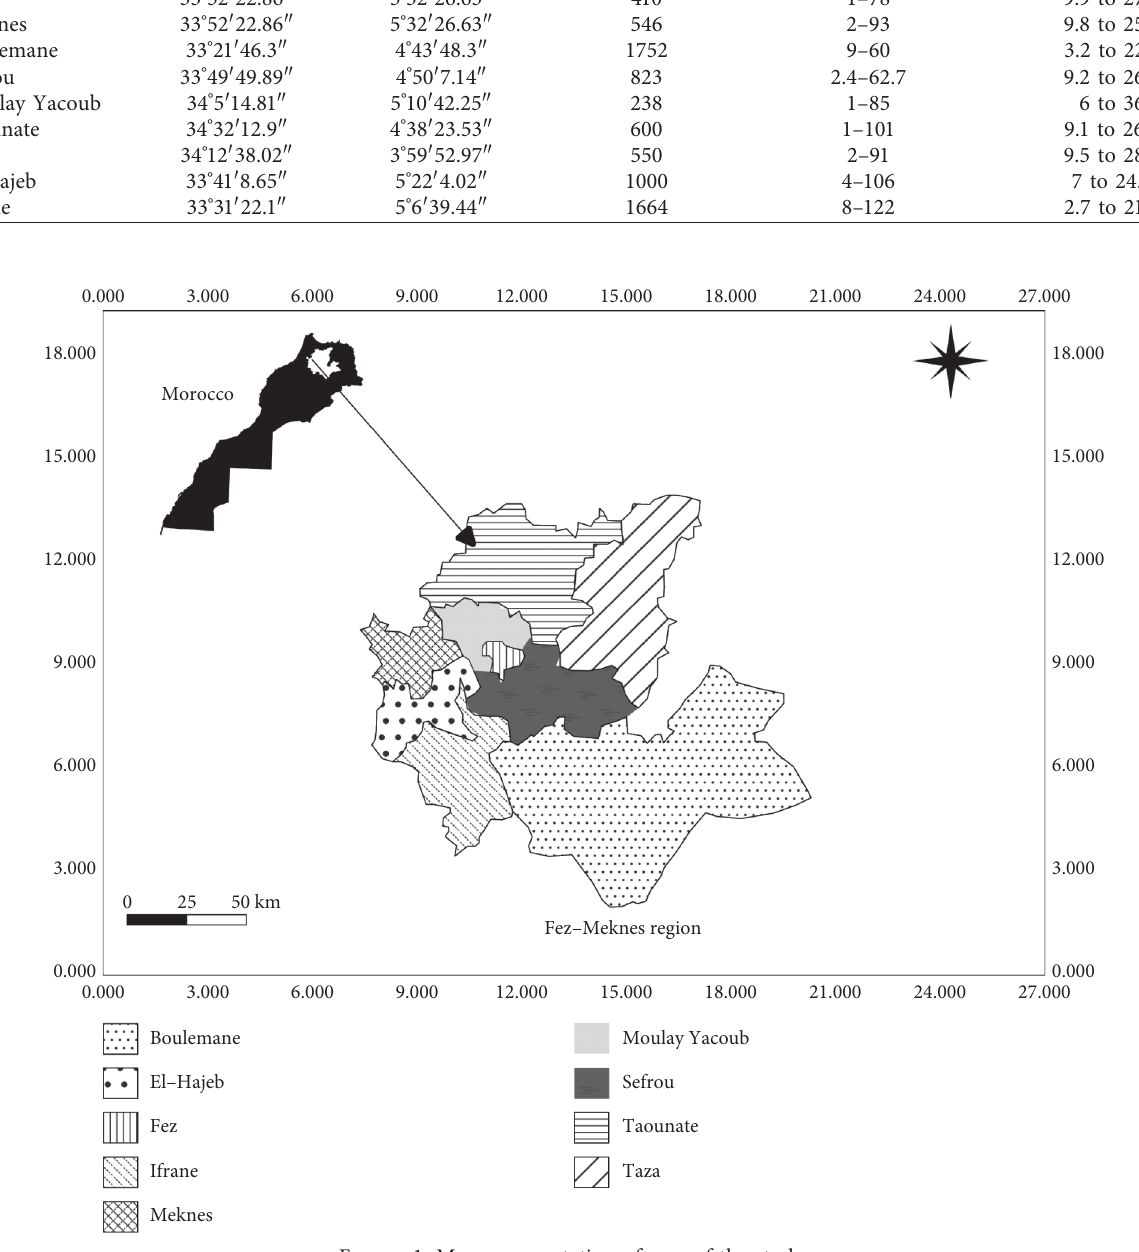
Figure 1: Map representation of area of the